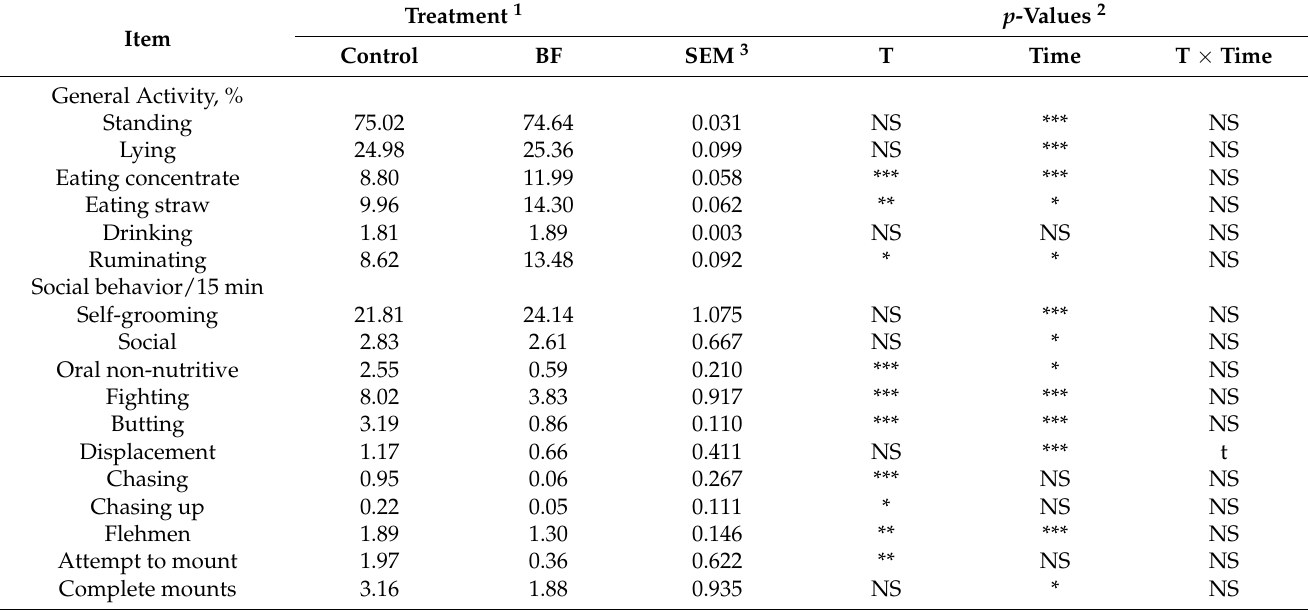
Table 4. General activities (%) and social behavior (times/15 min) for growing phase in Holstein bulls fed high-concentrate diets supplemented with citrus